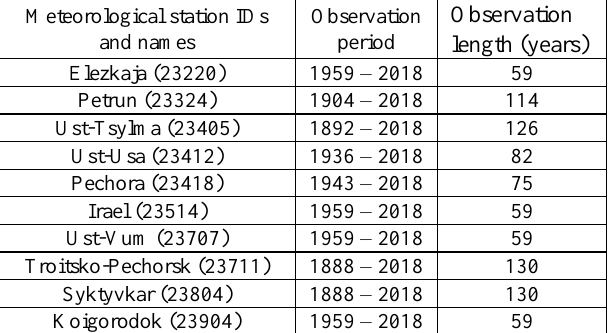
Table 1. Republic of Komi meteorological